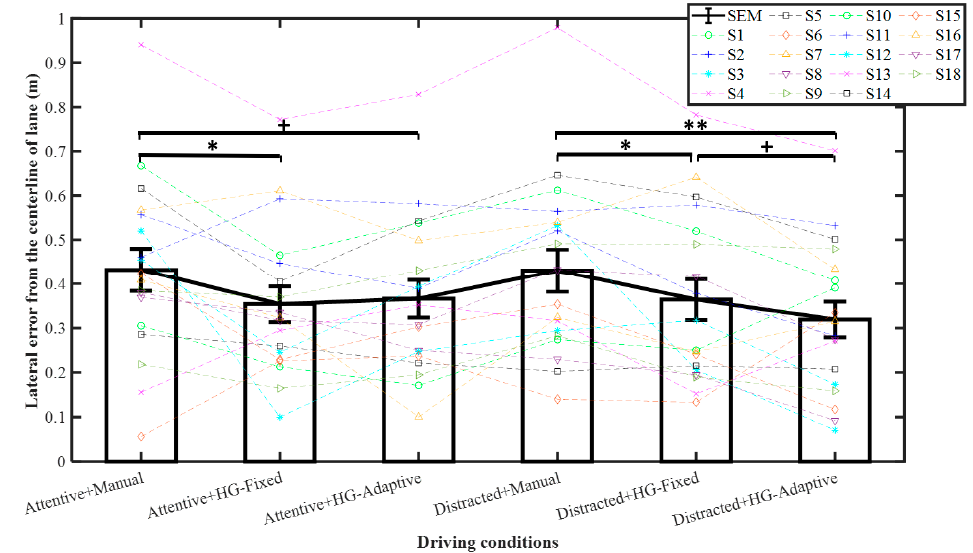
Figure 6. Lateral error with respected to lane centerline at end of first lane change. Mean +/ − SEM represented by error bars. + p < 0.1, * p < 0.05, and ** p < 0.01.